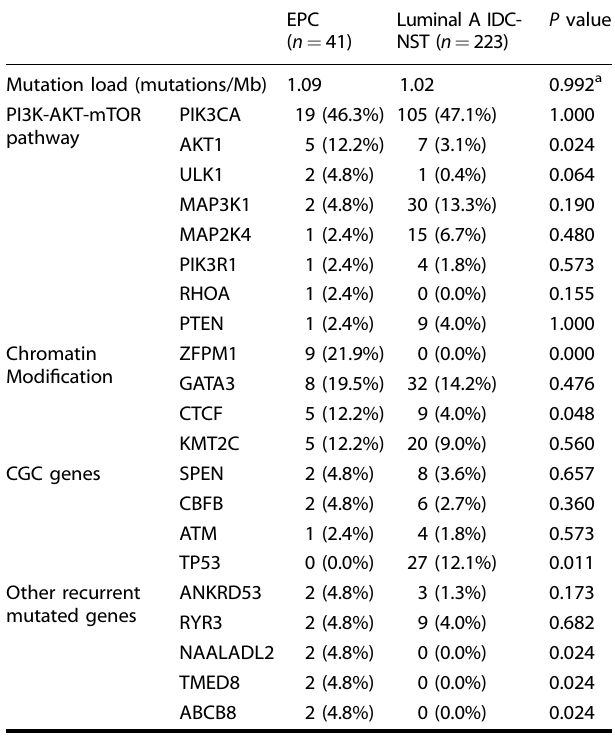
Table 2. Comparison the molecular features between EPCs and luminal A